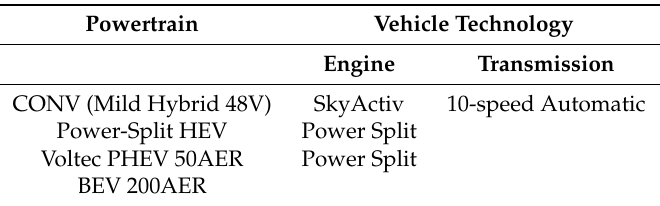
Table 2 details a subset of the different vehicle powertrains used to represent the fleets: Table 2. Autonomie Vehicle Models